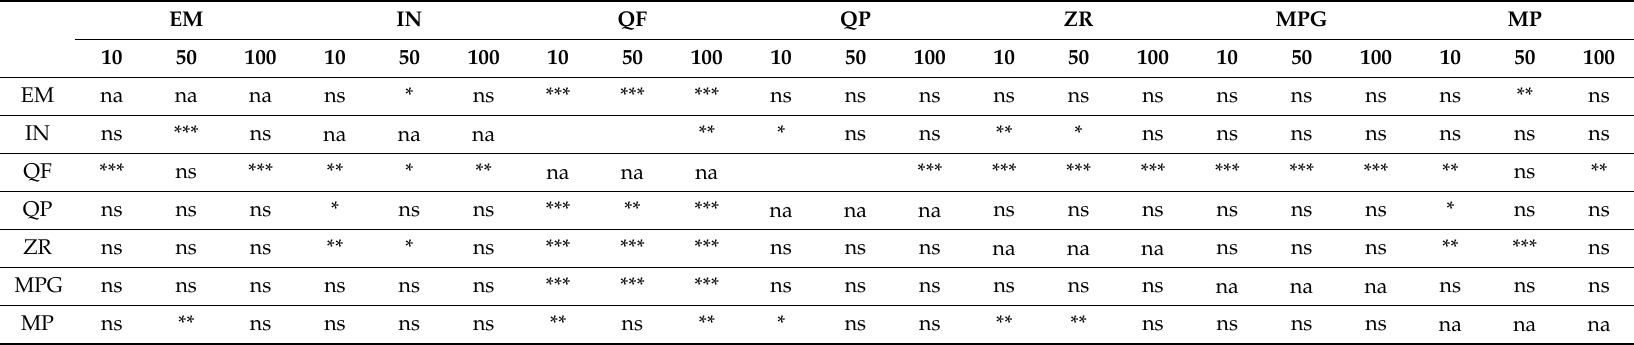
Table 5. Degrees of statistical significance of Chi2 tests comparing the percentage of positive C. parvum real-time PCR according to the pretreatment / extraction protocols for the concentrations of 10, 50, and 100 oocysts / mL.